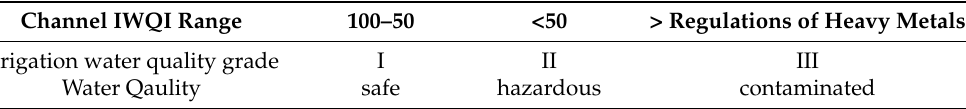
Table 2. Irrigation water quality